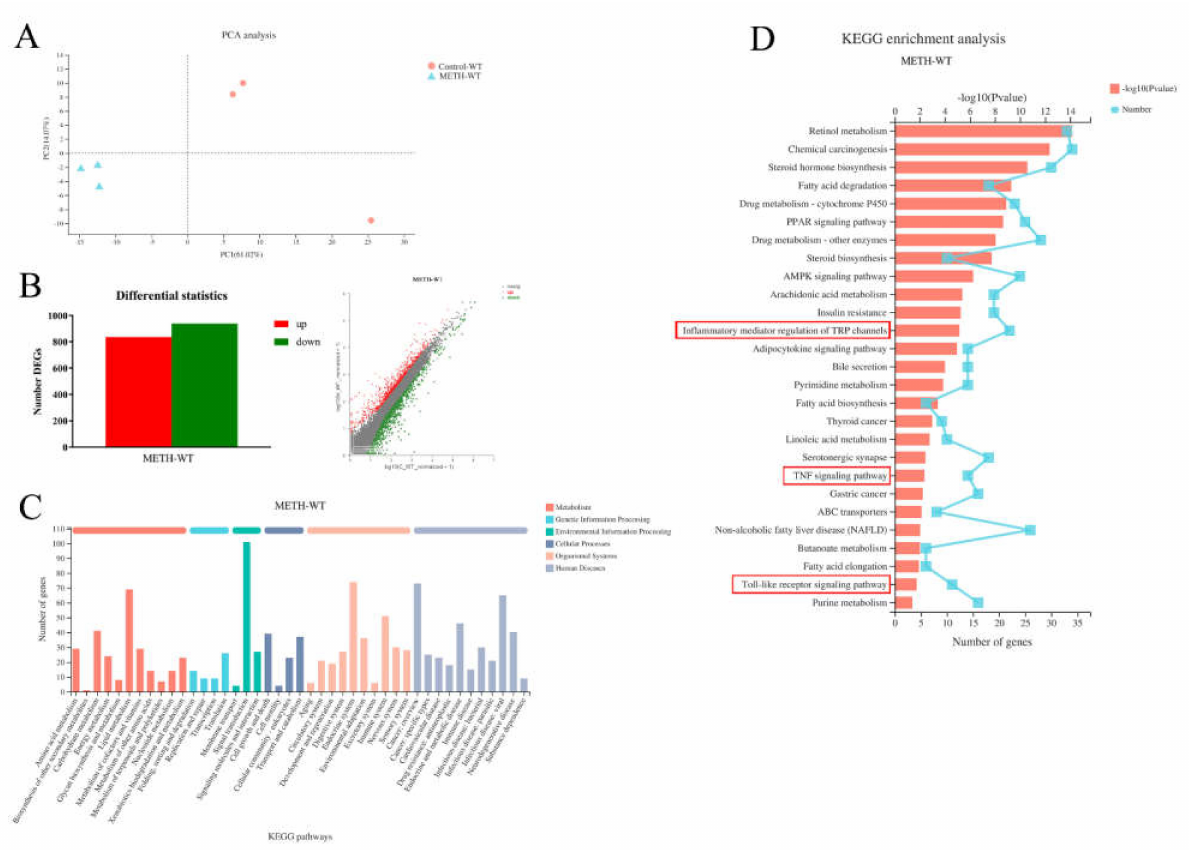
Figure 2. Inflammatory pathways were enriched in the mouse liver of the METH-treated group compared to the control by RNA-Seq analysis. ( A ) Principal component analysis; ( B ) Identification of DEGs using the histogram and scatter plot methods (|log2FC| ≥ 1, p -value < 0.05) in METH-treated wild-type (WT) group; ( C ) KEGG functional annotation analysis for metabolic pathways; ( D ) KEGG enrichment analysis in METH-treated WT mice. Inflammatory mediator regulation of TRP channels, the Toll-like receptor signaling pathway and the TNF signaling pathway (in the red boxes) were enriched and correlated with the inflammatory